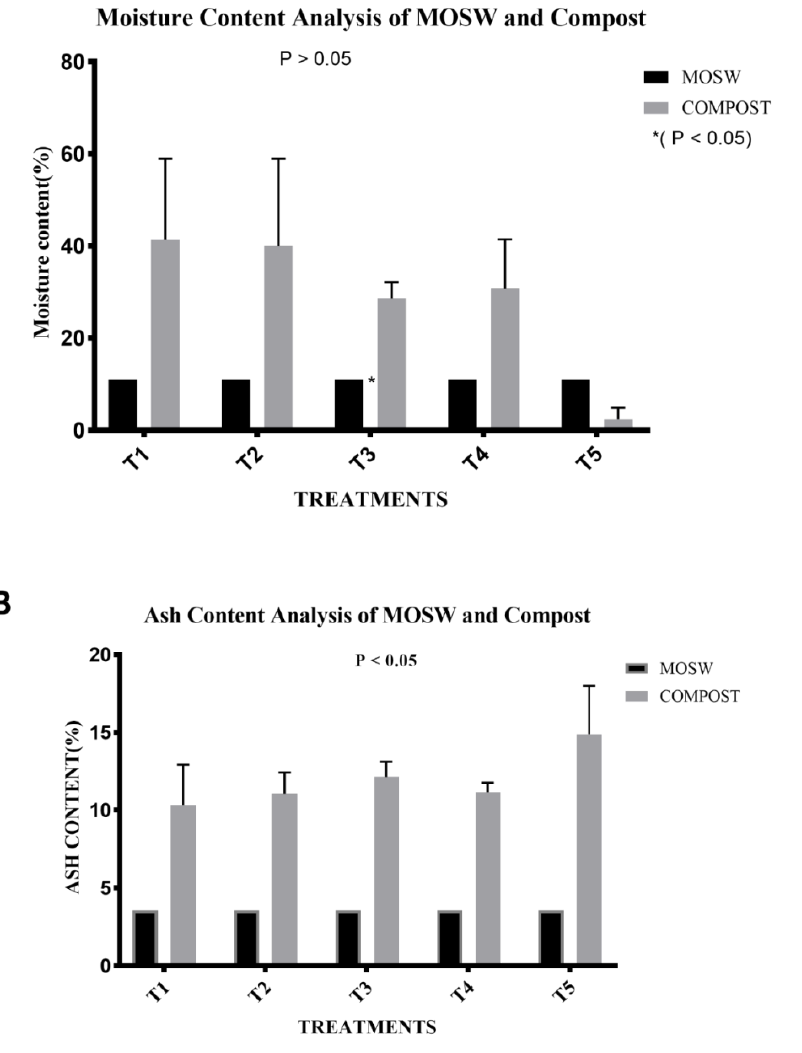
Fig. 3 Ash and moisture content analysis of MOSW and compost Graph bar with * have p<0.05; Mean (3) ± standard deviation. Mean measured in %. Treatments (T1) 50mg/larvae, (T2) 80mg/larvae, (T3) 100mg/larvae, (T4) 150mg/larvae and (T5)